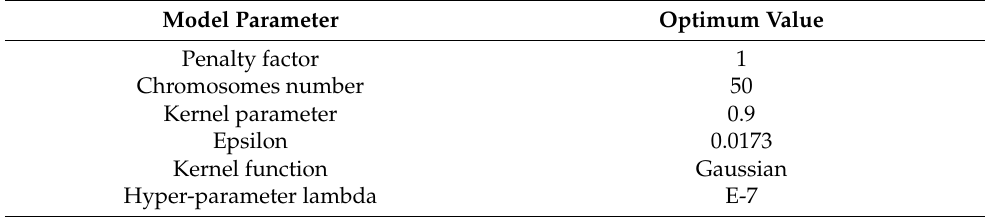
Table 2. Results of genetic algorithm for model optimization. Model Parameter